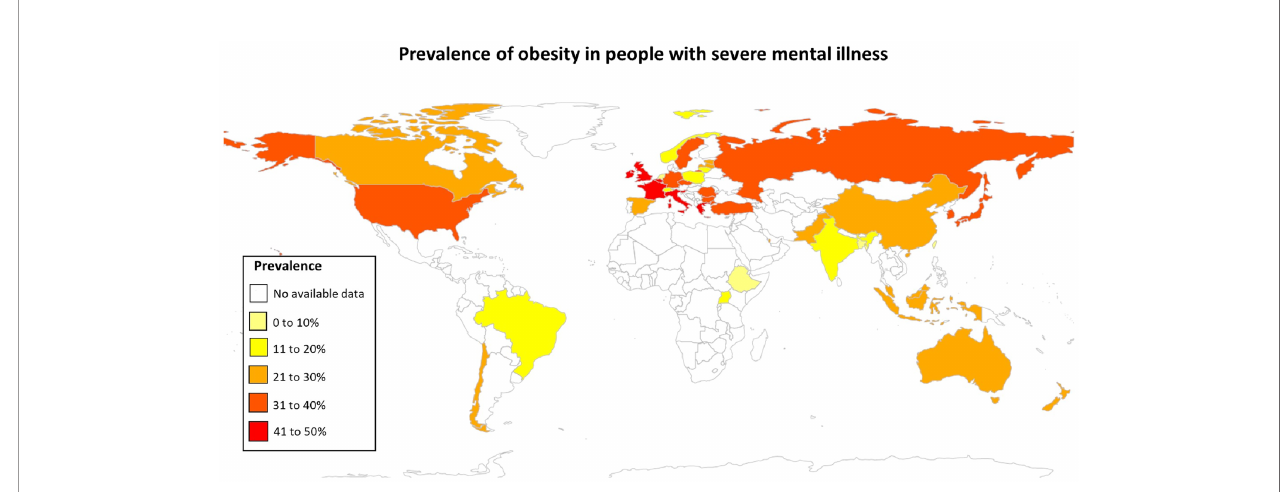
FIGURE 3 | Geographical variation in the prevalence of obesity in people with SMI.